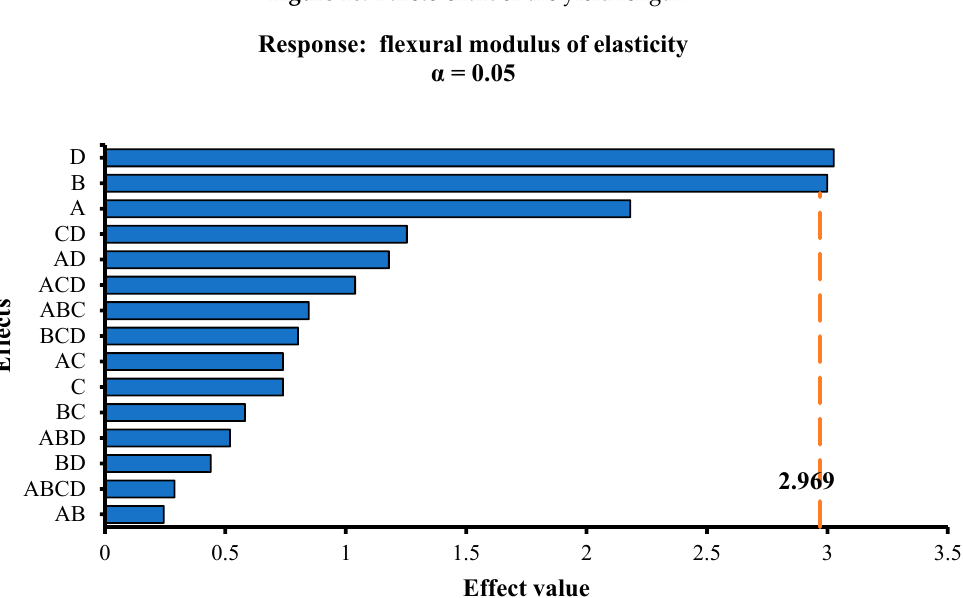
Figure 10. Pareto chart of the yield length.